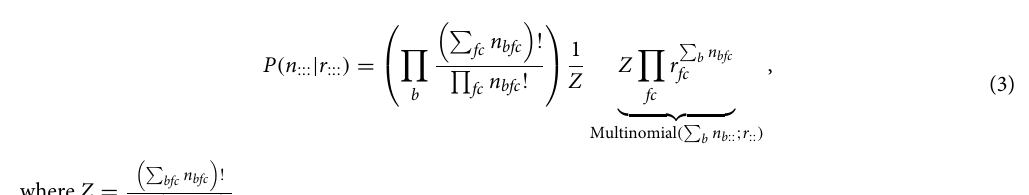
Figure 4. The data is best explained by a model where the caching rate depends on the bird identity and the food type but not on the compartment (red dashed bar at compartment independent). Prediction 1 and Prediction 2 of the Future Planning Hypotheses (FPH 1 and FPH 2, respectively) and the Compensatory Caching Hypothesis (CCH) have much lower posterior probability because they rely on compartment- and food-dependent caching rates. Because the compartment- and food-type-independent models assume that the caching rate for each of the three compartments and food types is 1/6, there is no difference between a bird- dependent and a bird-independent model (grey